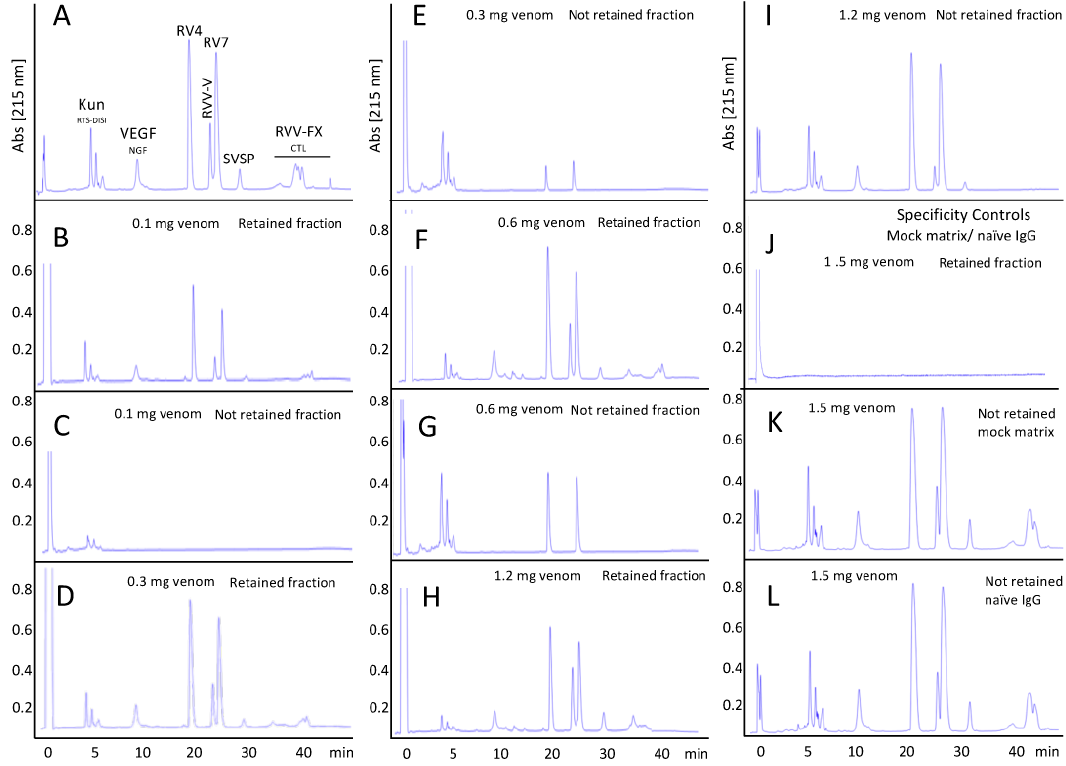
Figure 3. Third-generation antivenomics of CDC anti- Daboia siamensis antivenom. Reverse-phase chromatographic analysis of whole venom (panel ( A )) and of the non-retained and the immunoretained fractions recovered from affinity column (7 mg immobilized CDC-Taiwan anti- Daboia siamensis antivenom F(ab’) 2 molecules) incubated with increasing amounts (100–1200 μ g) of D. siamensis venom (panels ( B – I )). Panels ( J – L ), retained and non-retained venom fractions on mock matrix and naïve equine IgG affinity columns.